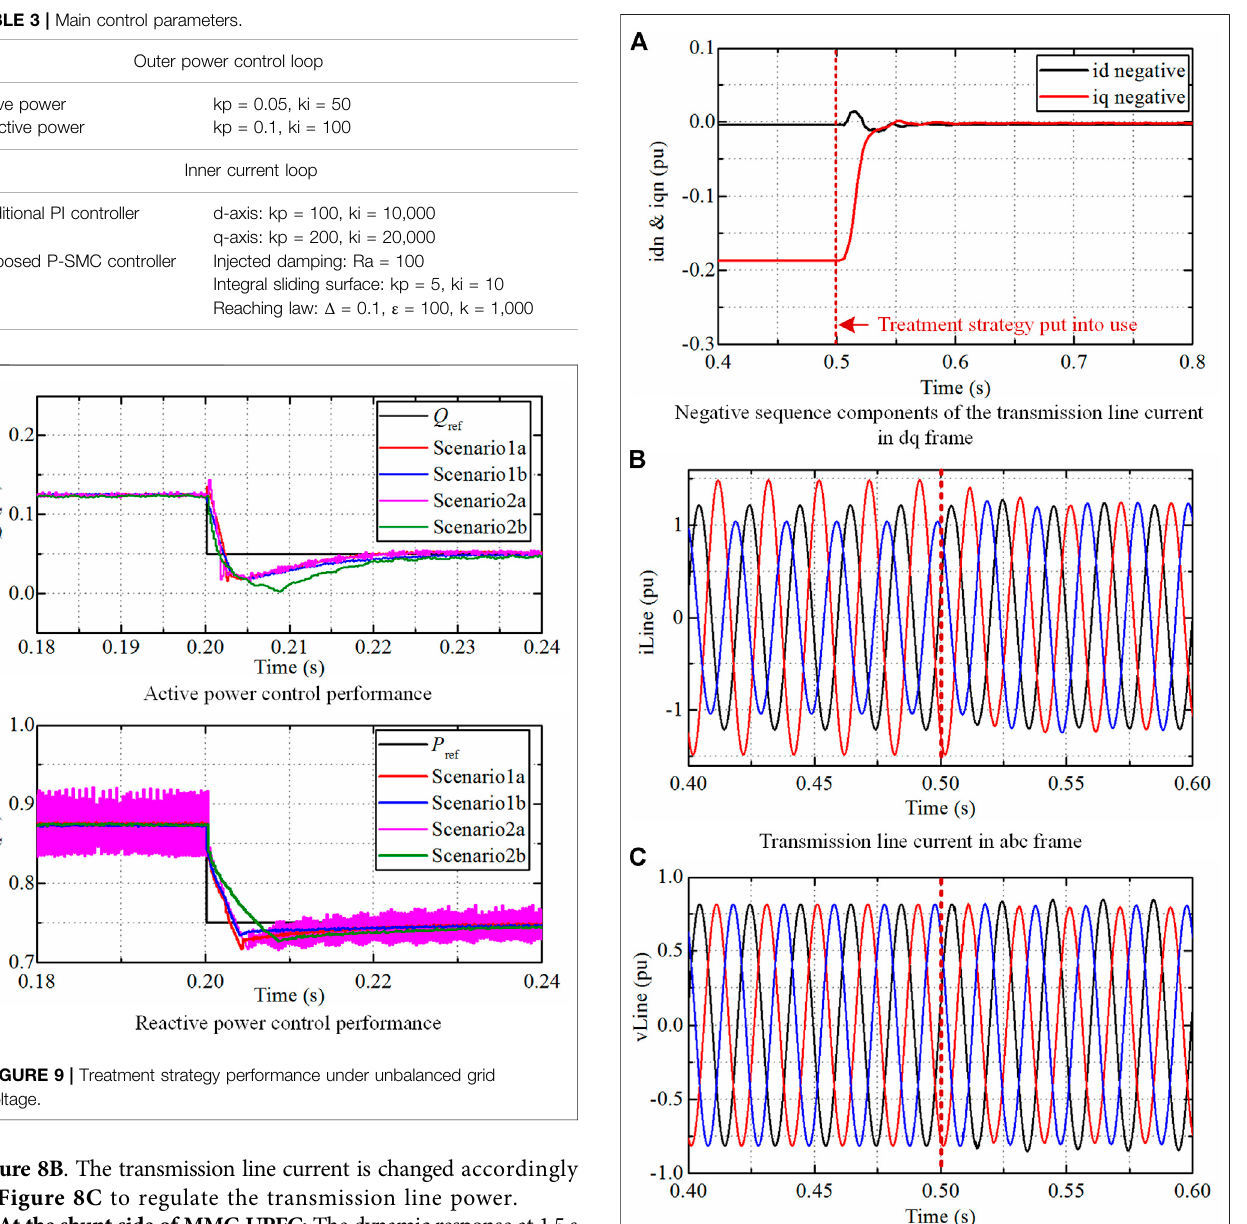
The P and Q reference values are changed from 0.875/